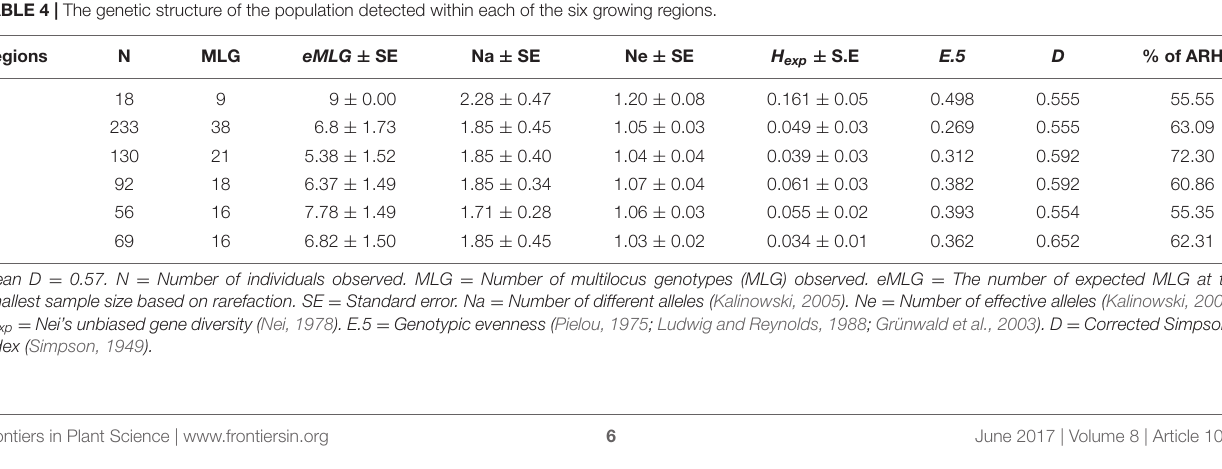
TABLE 4 | The genetic structure of the population detected within each of the six growing regions. Regions